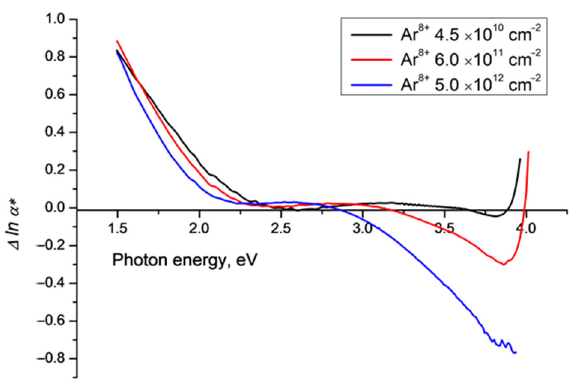
Figure 5. Difference functions ∆ ln α * ( ν ) for PET film samples irradiated with Ar 8+ ions of energy 1.75 MeV/a.u. and fluences of 4.5 × 10 10 cm − 2 , 6.0 × 10 11 cm − 2 and 5.0 × 10 12 cm − 2 , at an angle of 42° to the normal. Note the y axis scale is an order of magnitude larger than in Figures 2–4. The cut off in the UV region for the fluence of 5 × 10 12 cm − 2 (blue line) before the difference function returns to positive is due to experimental limitations on the number of data points in this region (for more details, see [16] and [17]).